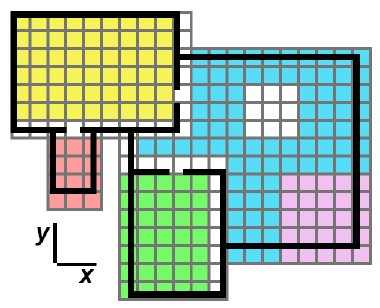
Figure 1. Perpendicularity of the zone’s borders